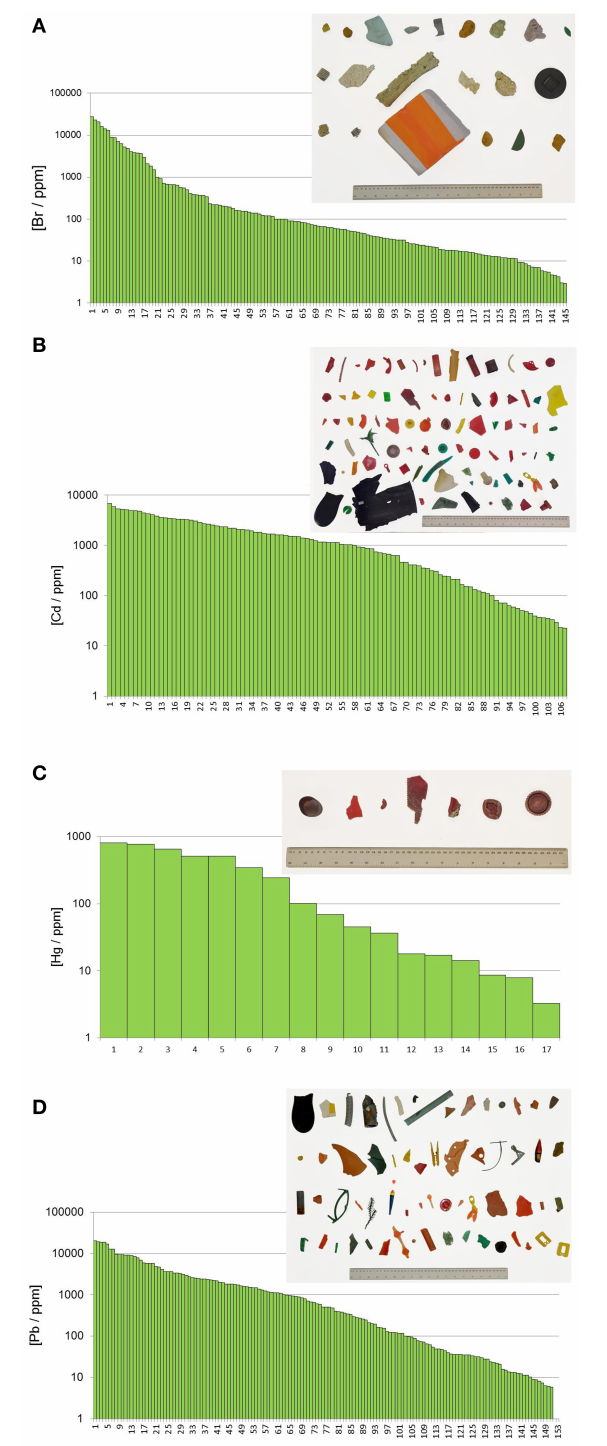
FIGURE 2 | (A) Distribution of measured bromine concentrations. The picture shows all objects with concentrations higher than 1,000 ppm and in descending order from left to right and from top to bottom. (B) Distribution of measured cadmium concentrations. The picture shows all objects with